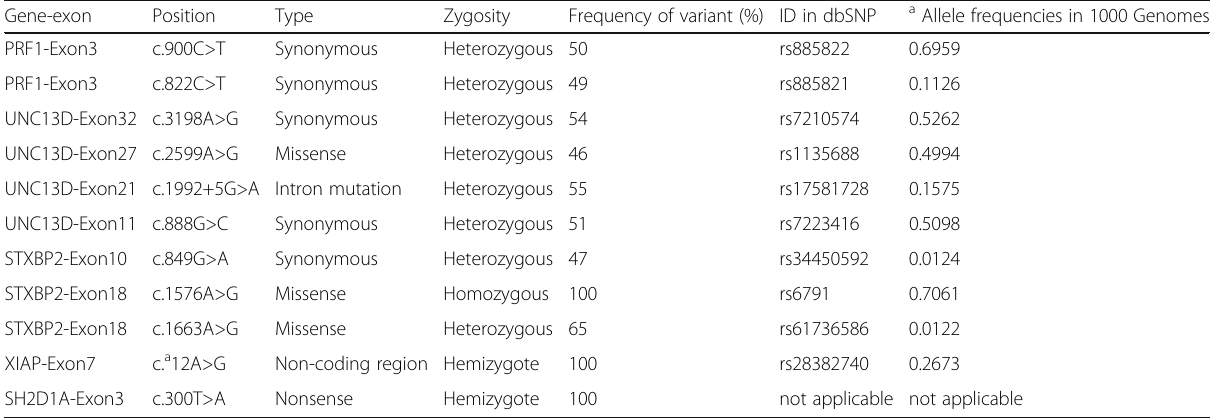
Table 1 Identified mutations in the patient with XLP1 Gene-exon Position Type Zygosity Frequency of variant (%) ID in dbSNP a Allele frequencies in 1000 Genomes